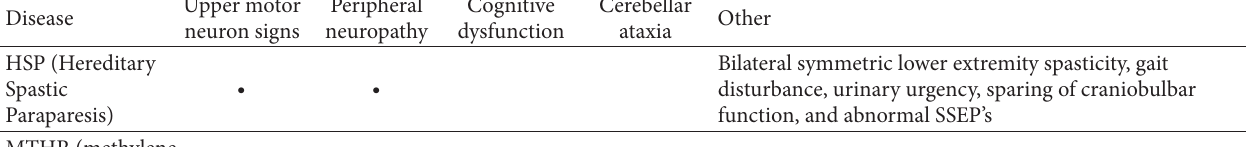
Table 1: Differential diagnosis of lower extremity weakness and